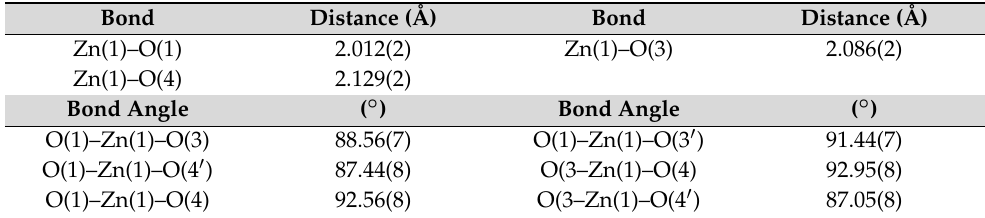
Table 1. Selected bond distances and angles for complex 3